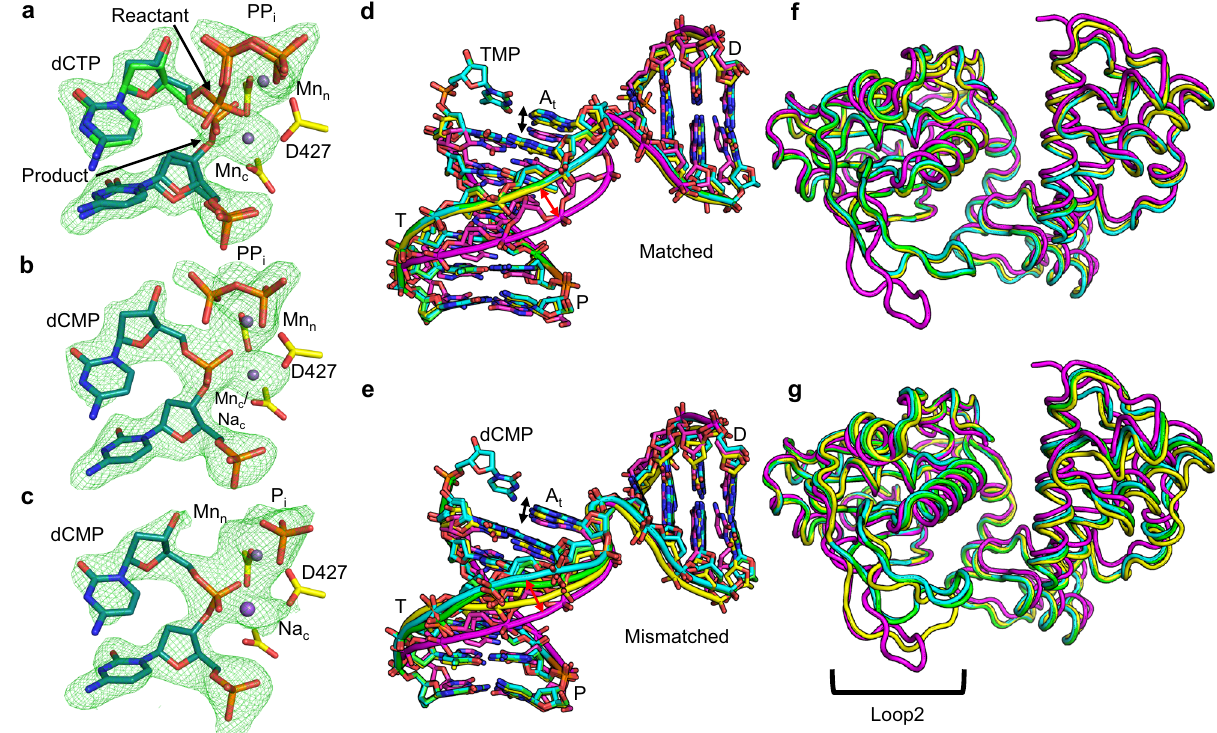
Fig. 5 Mismatch incorporation. a Mismatch Mn 2 + -reaction state ternary complex after a 225 min soak. b Mn 2 + -mismatch product state (PS Mn ) after a 420 min soak. c Extended soak of the Mn 2 + -mismatch product (PS Mn ES ) complex. In ( a ), ( b ) and ( c ) dCTP is shown in green stick representation, DNA in cyan, sidechains are yellow. Smaller magenta spheres are Mn 2 + , the large purple sphere is Na + . Simulated annealing omit (F o -F c ) density is shown as a green mesh contoured at 2.5 σ , carve radius 2.0 Å. Global conformational changes in DNA during ( d ) matched and ( e ) mismatched insertion. Structural overlays of the binary complex (magenta), Ca 2 + -GS (yellow), RS Mn (cyan), PS Mn (green) are shown. Template (T), primer (P) and downstream (D) strands are indicated. DNA phosphate backbone is shown as a tube, nucleotides are shown in stick representation. Global conformational changes in protein backbone during matched ( f ) and mismatched ( g ) nucleotide insertion. A bracket highlights loop 2 of the